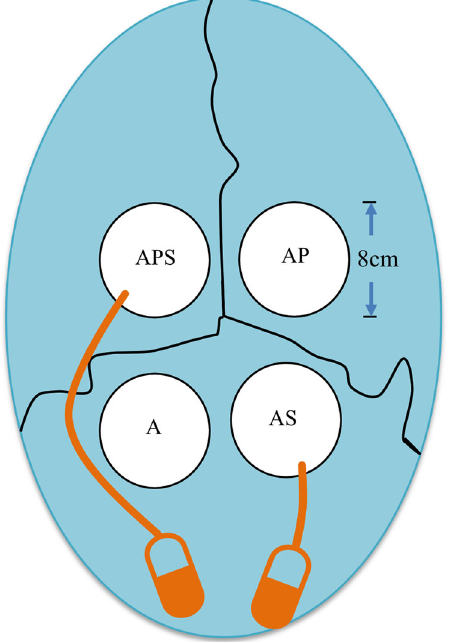
Fig. 1 Diagram showing the four evenly distributed surgical defects (8 mm diameter), allocated in the calvarial bones of each rabbit. A group, autogenous bone particles alone (AB); AS group, AB + SDF- 1 α ; AP group, AB + PRP; APS group, AB + PRP + SDF-1 α .